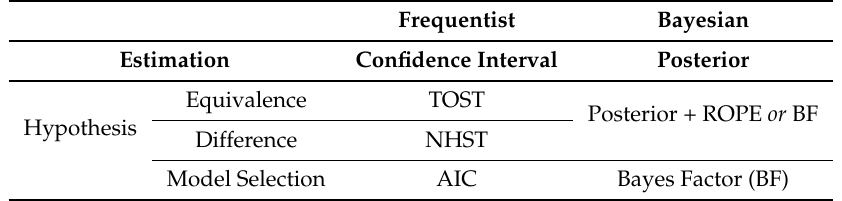
Table 5. Overview of different statistical methods. TOST stands for Two One-Sided T-Tests and AIC is the Akaike Information Criterion [105], a combined measure for model fit and model